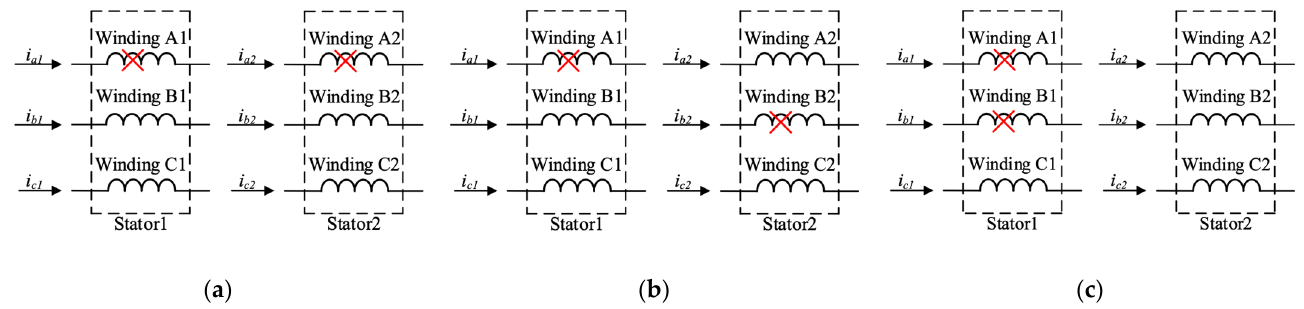
Figure 13. Winding configurations of two-phases open-circuited under three fault cases. ( a ) Case I; ( b ) Case II; ( c ) Case III. In case I, the two groups are phase B1, C1 and phase B2, C2, respectively. The regulated current and total magnetomotive force are given as Equations (14) and (15), respectively. And the phasor diagram of the regulated current under Case I is given in the Figure 14 in addition.